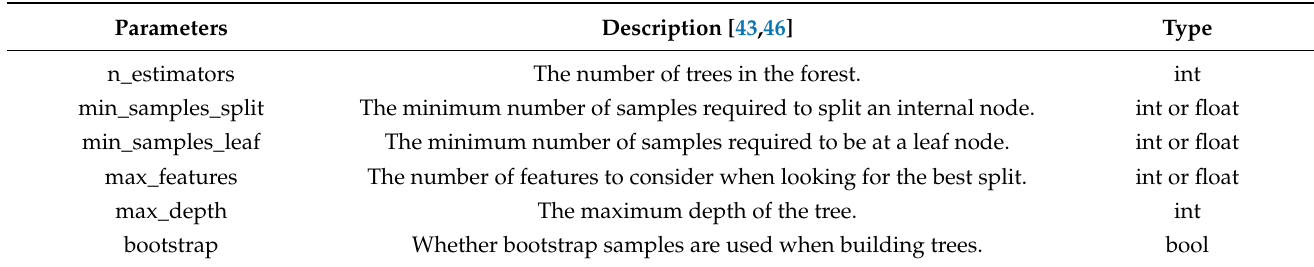
Table 3. Description of random forest algorithm optimization